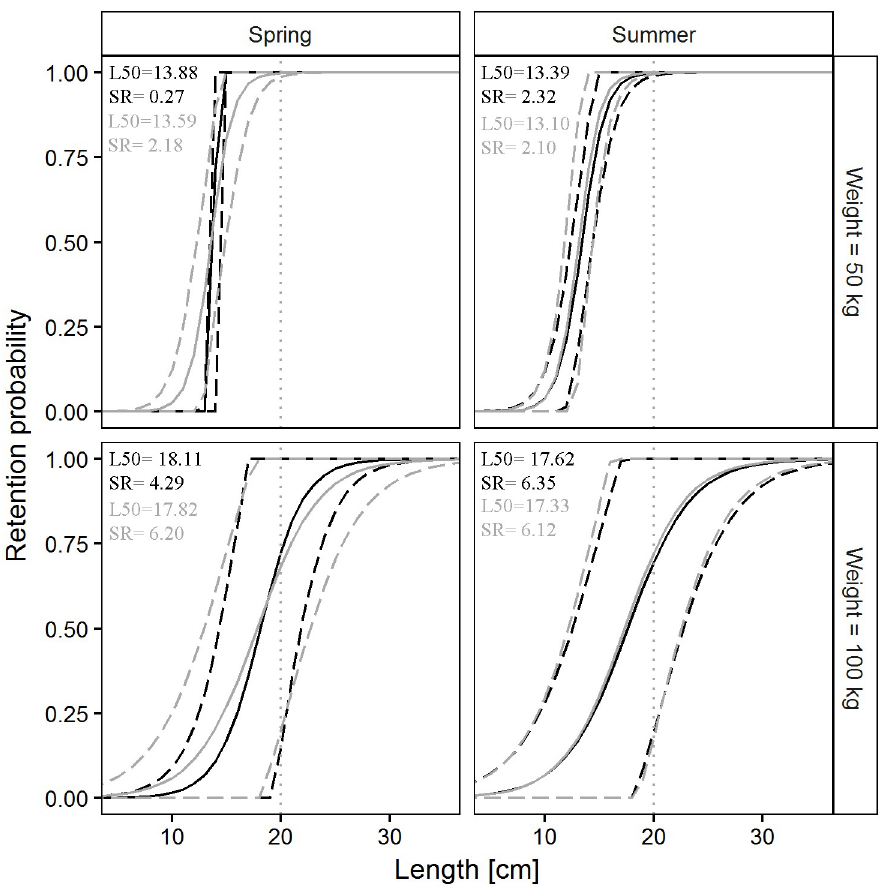
Fig 5. Differences in European hake retention probability between the SM40 (black) and the DM50 (grey) codend in four simulated scenarios. Dashed lines: 95% CI for the mean curve (solid line); dotted vertical line: MCRS for European hake (TL, 20